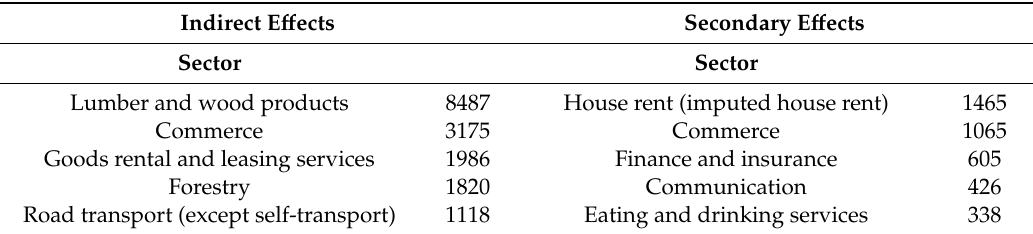
Table 7. The top five sectors for the indirect and secondary e ff ects of constructing a timber check dam (unit is thousand yen).